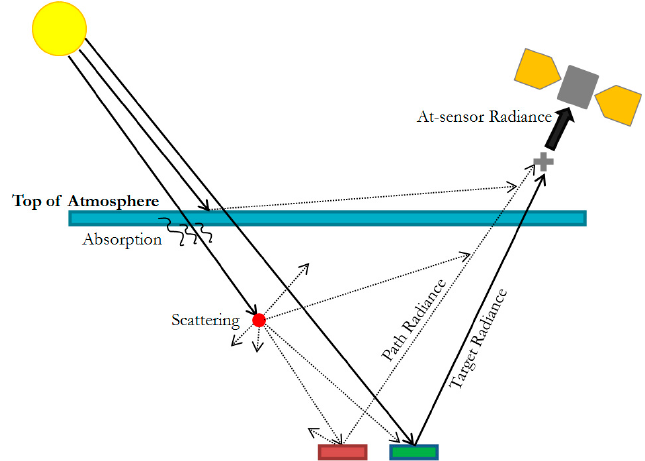
Figure 1. Scheme of how satellite sensor captures surface radiance. The difference between the target radiance and path radiance is also shown.